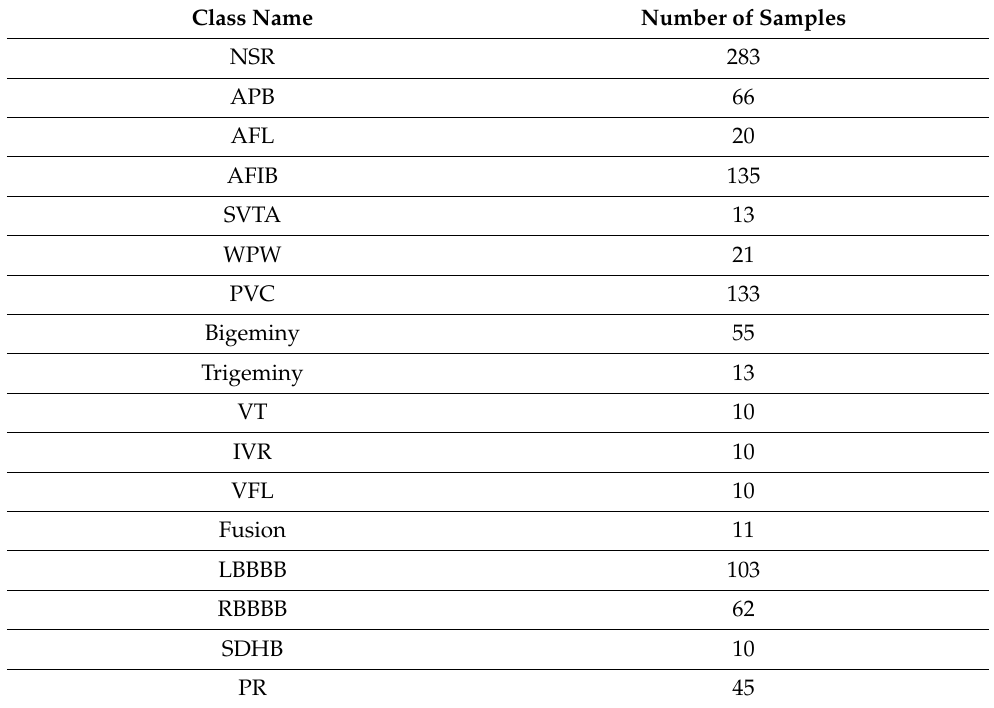
Table 1. Summary of dataset